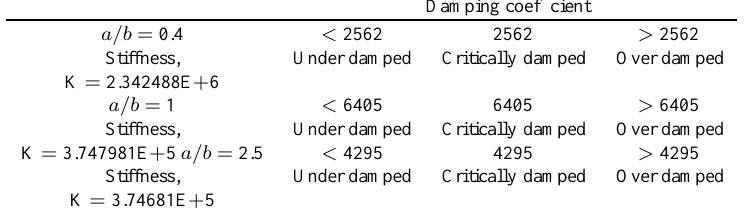
Table 6 Damping state for different aspect ratio